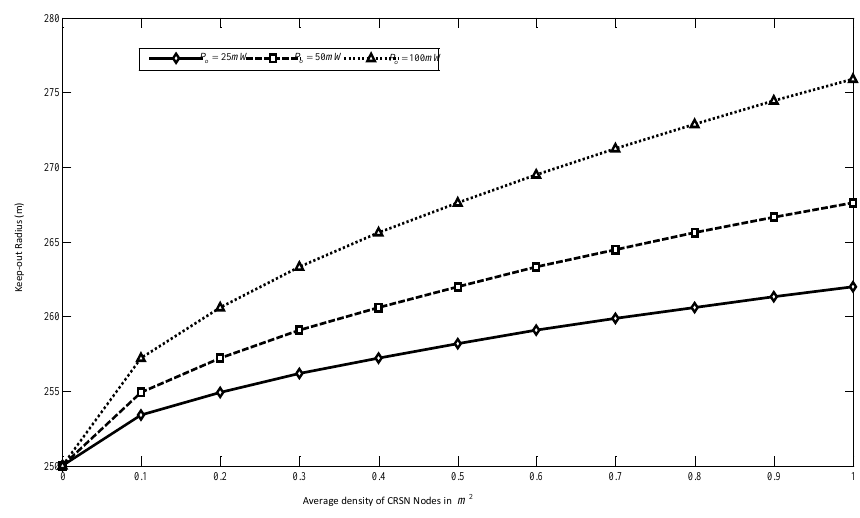
Figure 10. Effect of keep-out radius in routing for cognitive radio sensor networks (CRSNs).